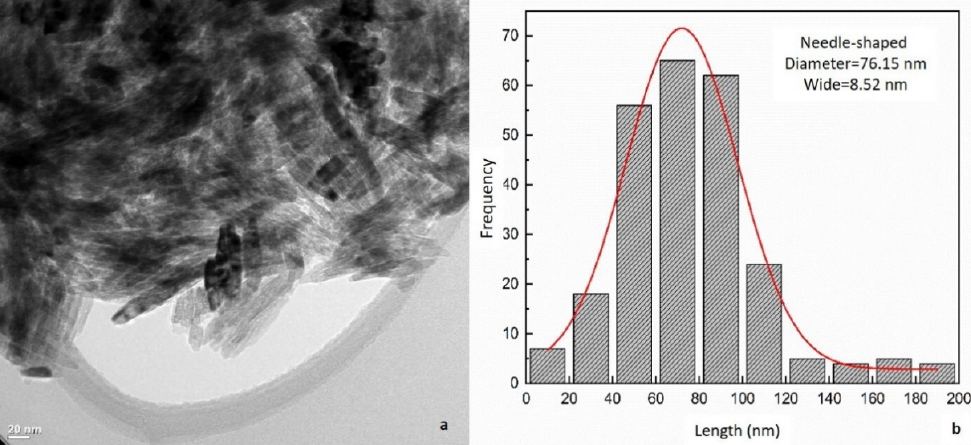
Figure 2. Transmission electron microscopy micrograph showing the needle-shaped morphology of TiO 2 NPs ( a ) and histogram of particle size distribution ( b ).